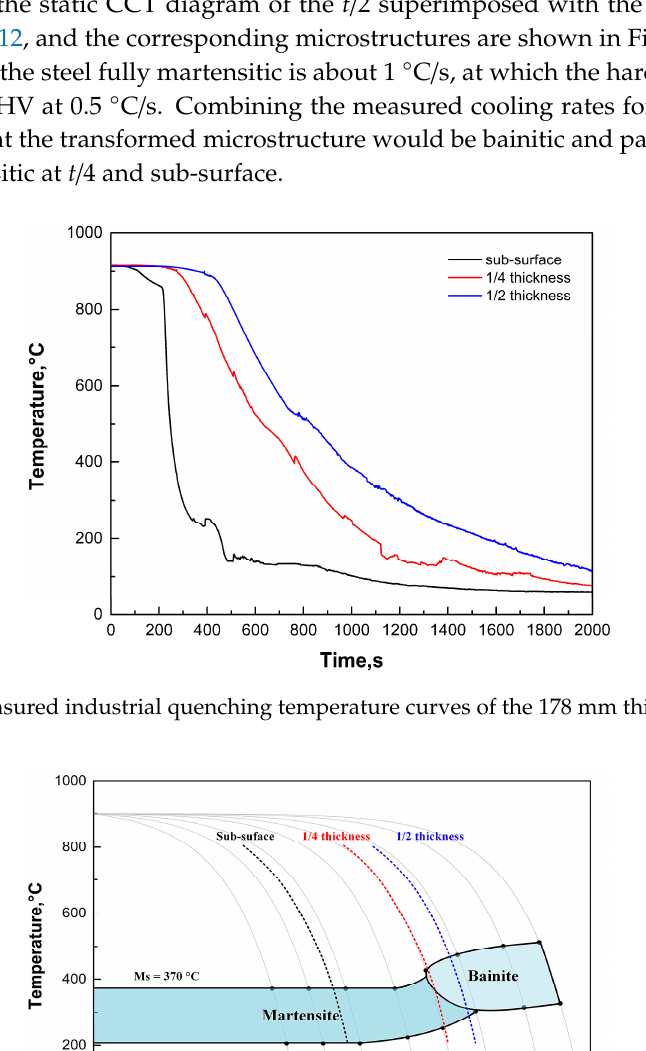
Figure 14. Optical micrographs of the t /2 specimens after continuous cooling at ( a ) 0.2 °C/s, ( b ) 0.5 °C/s, ( c ) 1 °C/s, ( d ) 2 °C/s, ( e ) 5 °C/s, ( f ) 10 °C/s. 4. Discussion 4.1. Thickness Effect on Microstructure Variation Based on the temperatures recorded during quenching and the CCT diagram plotted from experiments, the resulted microstructures at the typical positions of the 178 mm thickness plate, produced by quenching and tempering, could be interpreted by the quantitative effect of thickness on the transformation, especially at t /2. The critical cooling rate to form full martensite is about 1.0 °C/s for the investigated steel. The cooling rate at the middle thickness during quenching was measured as 0.6 °C/s, much lower than the critical cooling rate, meaning that only partial martensite